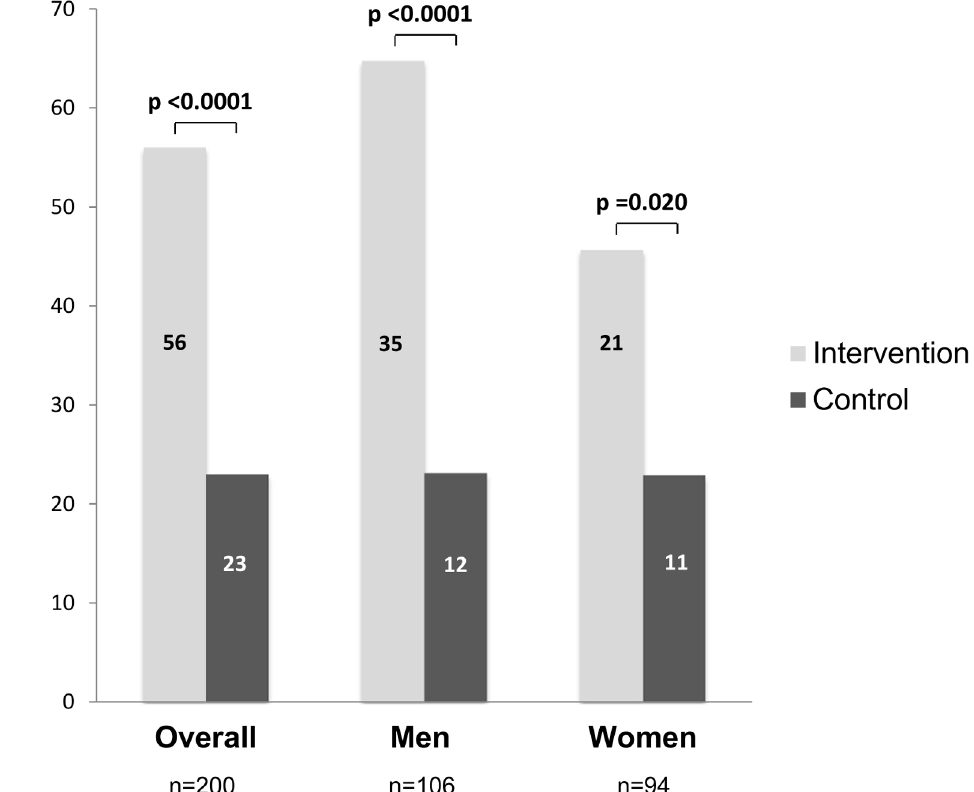
Fig 3. Sputum smear positive microscopy results in the intervention (exposure to the sputum submission instruction video) and control group (standard of care), overall and stratified by sex. Numbers on the bars indicate absolute number of patients.